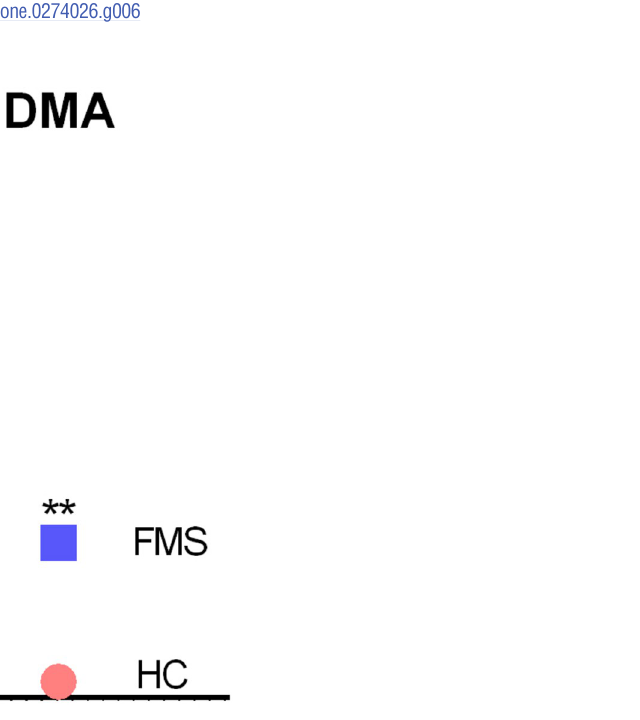
Fig 7. Z-adjusted values of dynamic mechanic allodynia measured in quantitative sensory testing in FMS patients relative to healthy controls. �� p < 0.001; we used ANOVA for statistical testing. DMA = dynamic mechanical